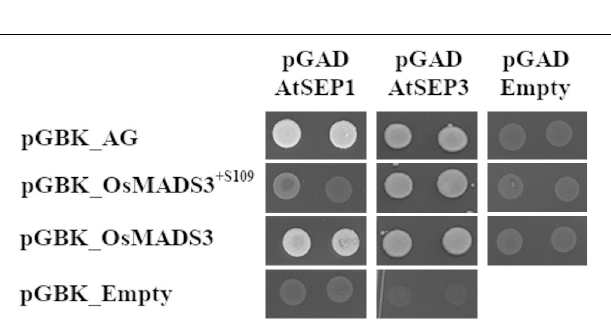
FIGURE 6 | Expression of REM22, SPL, and SHP1 in transgenic plants in the ag-3 background. For each experiment, three biological replicates were used and for each of these three technical replicates were done. The expression levels have been normalized against the WT. SEM is indicated.